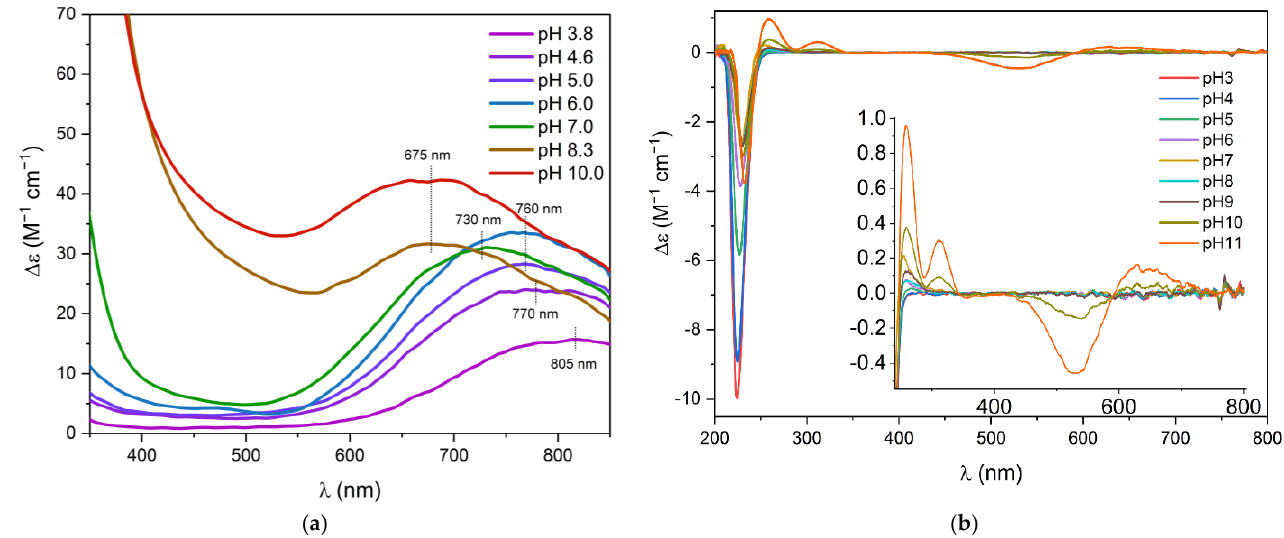
Figure 3. ( a ) Vis absorption spectra and ( b ) CD spectra of Cu 2+ complexes with L3 at different pH values; M:L ratio 0.8:1. C M = 0.56 × 10 − 3 M, optical path 1 cm. The wavelength of maximum absorption is reported for each Vis absorption spectrum.